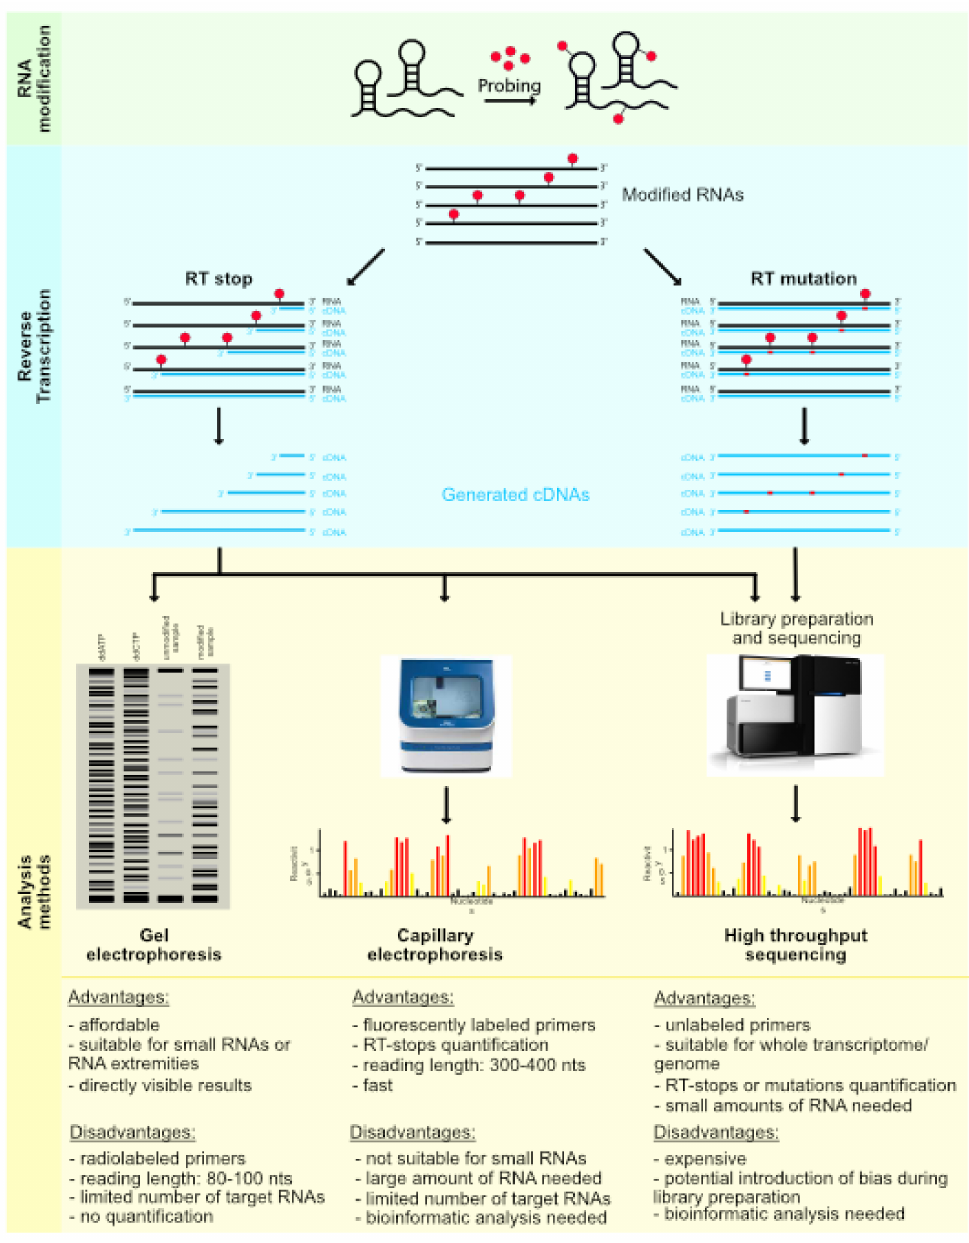
Figure 3. Schematic representation of RNA probing methods based on chemical modification. Folded RNAs were modified with the chemical probe of interest (green panel). For the RT stop strategy (left, blue panel), modified RNAs were reverse-transcribed with (1) radiolabeled primers for gel electrophoresis visualization (left, yellow panel), (2) fluorescently labeled primers for capillary elec- trophoresis detection (center, yellow panel), or (3) unlabeled primers for high-throughput sequencing after adapter ligation and library preparation (right, yellow panel). For the mutational profiling approach (right, blue panel), the modified RNAs were reverse-transcribed under mutation-inducing conditions with unlabeled primers. The cDNAs were ligated to adapters, and a library was prepared for high-throughput sequencing (right, yellow panel). The main advantages and disadvantages of the three analysis methods were featured at the bottom of the yellow